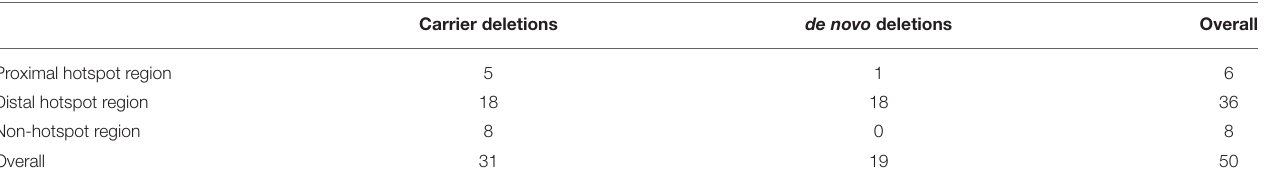
TABLE 2 | Number of patients with BMD who had deletions located in the proximal, distal hotspot region and non-hotspot region.